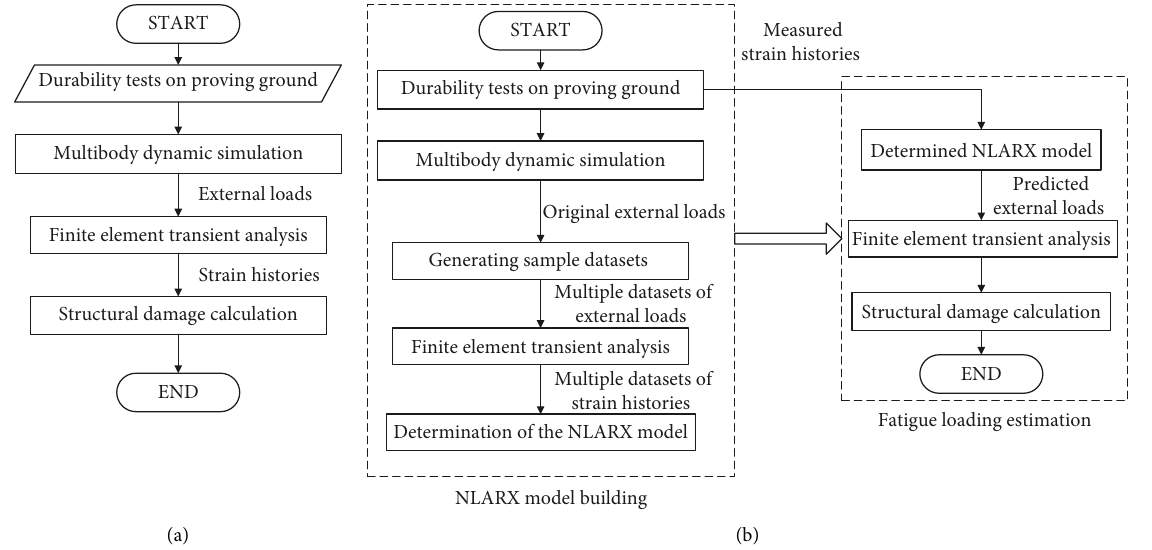
Figure 1: Framework of (a) semianalytical method; (b) the proposed